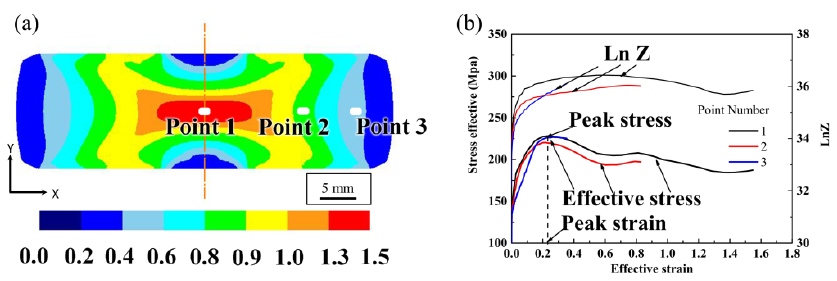
Figure 4. Thermo-mechanical parameters of double cone specimen compressed at 1010 ° C. ( a ) Effective strain distribution at cross section, point 1, 2, 3 locates in the center, 1/2 radius and edge of specimen, respectively; ( b ) Effective stress and LnZ versus with effective strain of point 1,2,3 shown in ( a ).